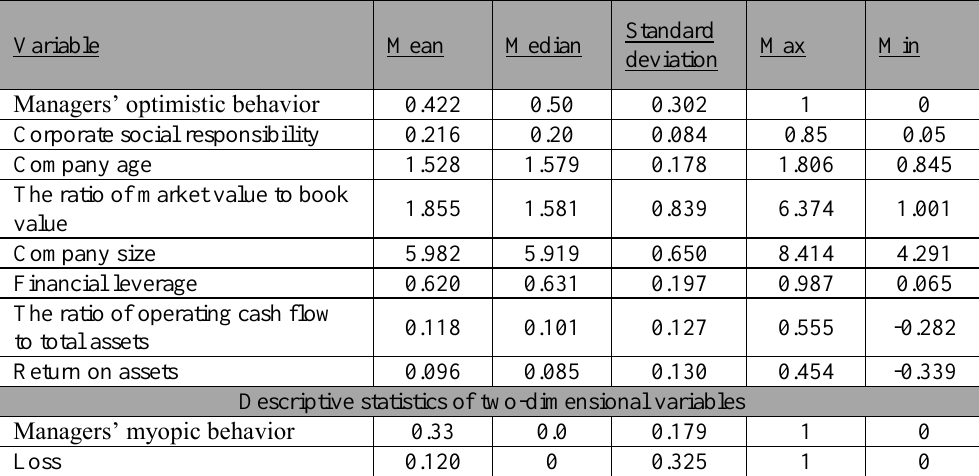
Table 4. Descriptive statistics of research